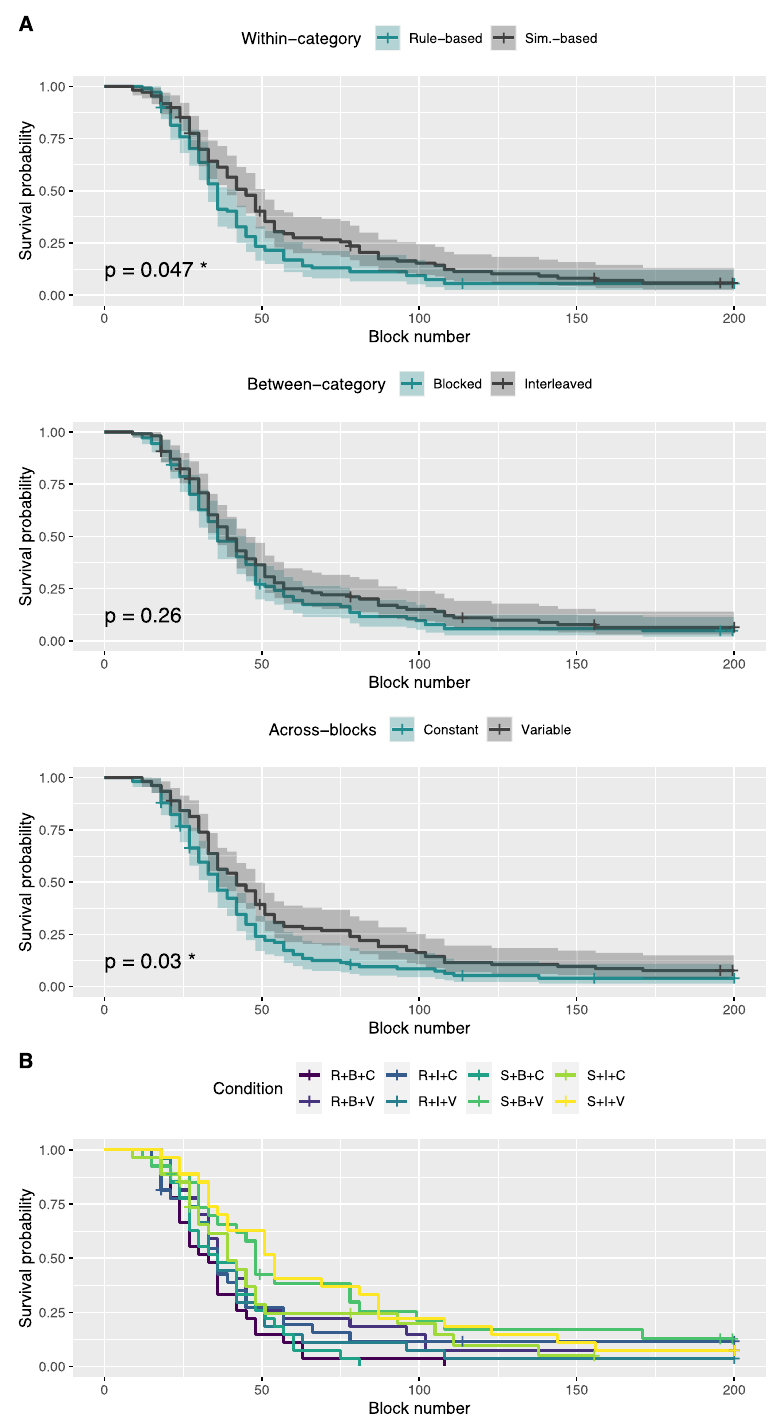
Figure 3. Kaplan-Meier survival curves as a function of block number for each type of order, taken separately ( A ) and combined ( B ). Transparent areas represent the 95% confidence intervals. Significance values of the log- rank test assessing the difference between survival curves are showed on the bottom-left side of each graph of ( A ). Significance values were corrected for multiple comparisons using the Benjamini-Hochberg correction with a FDR ≤ .05